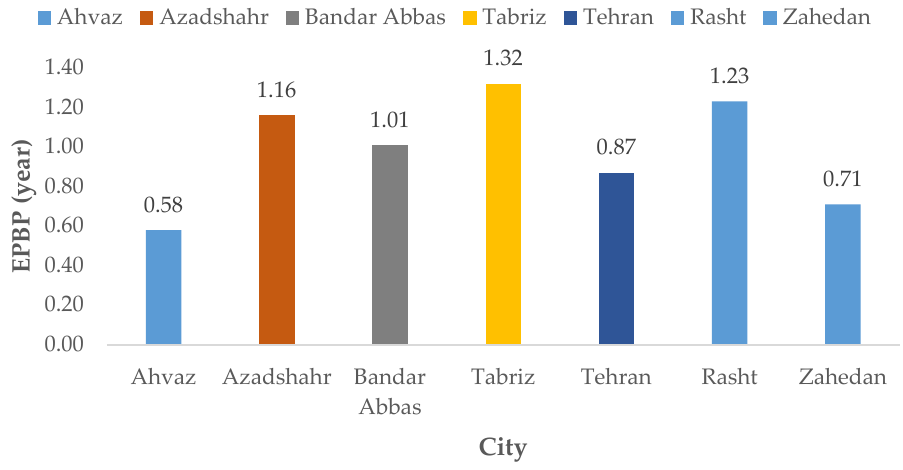
Figure 6. Comparing EPBP for seven investigated cities.